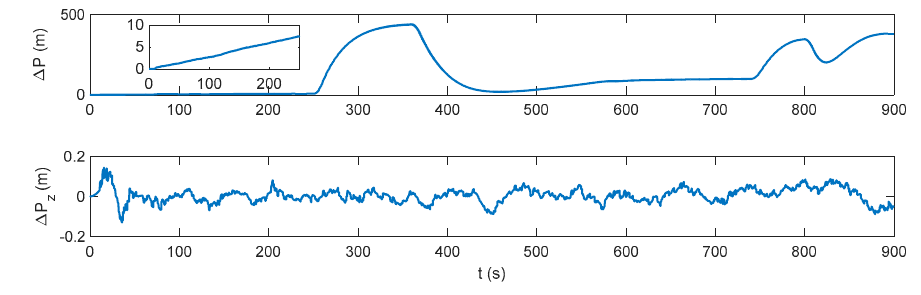
Figure 8. Position error of the INS/ZUPT solution.